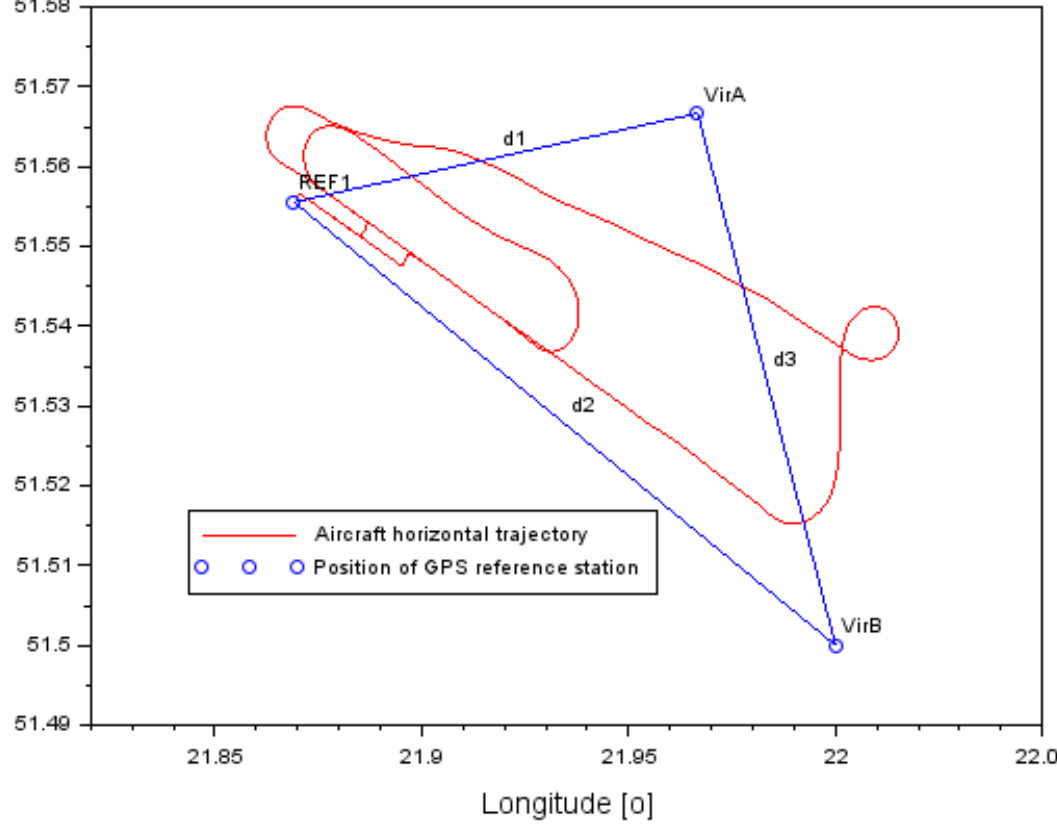
Figure 5. Horizontal trajectory of Cessna 172 aircraft.